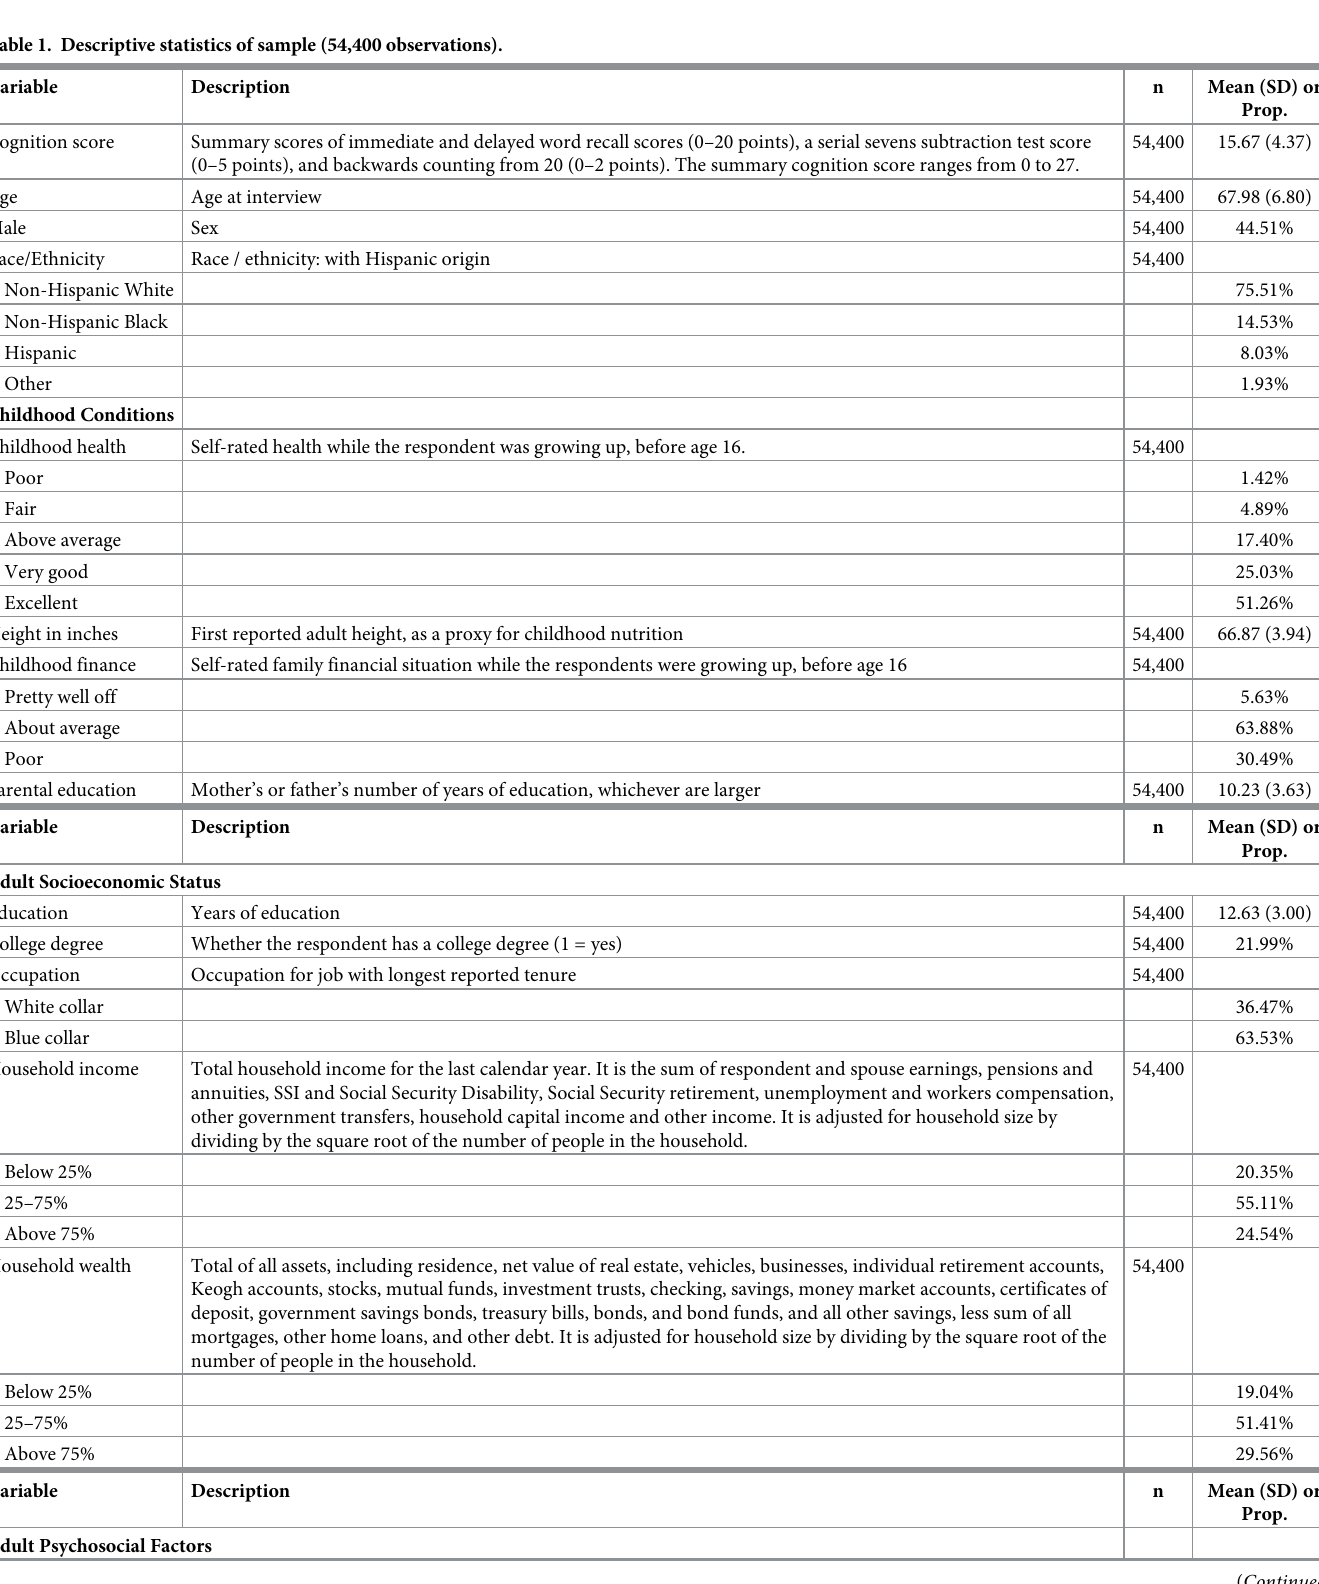
Table 1. Descriptive statistics of sample (54,400